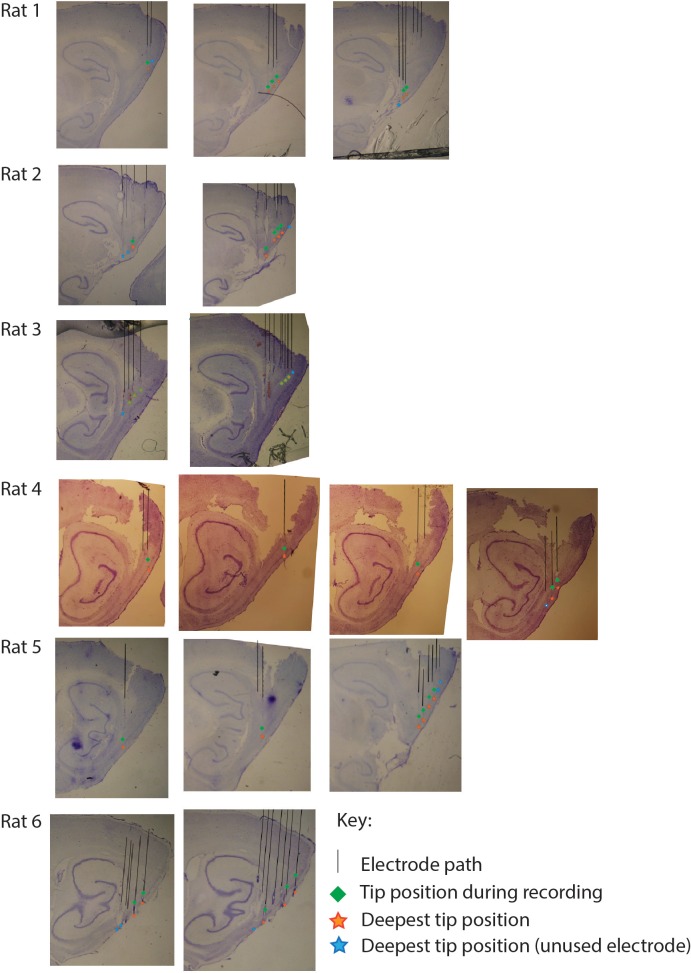
Histological micrographs for the six rats implanted for this study, marking estimated electrode placement at the time of sacrifice (orange and blue stars) and inferred positions at the time of the recording analyzed and described in the main text (green squares).Black lines were added to indicate the inferred electrode track. Stars were added to indicate the inferred final electrode position. Blue reflects electrodes that were found to be outside of the medial entorhinal cortex at the time of the key recording. Orange reflects electrodes that were found to target the medial entorhinal cortex at the time of recording. Note that, in most cases, key recordings upon which analyses were performed are relatively dorsal from the final termination sites shown here, because electrodes were often stepped deeper in an effort to achieve subsequent recordings of unit activity in layer II.